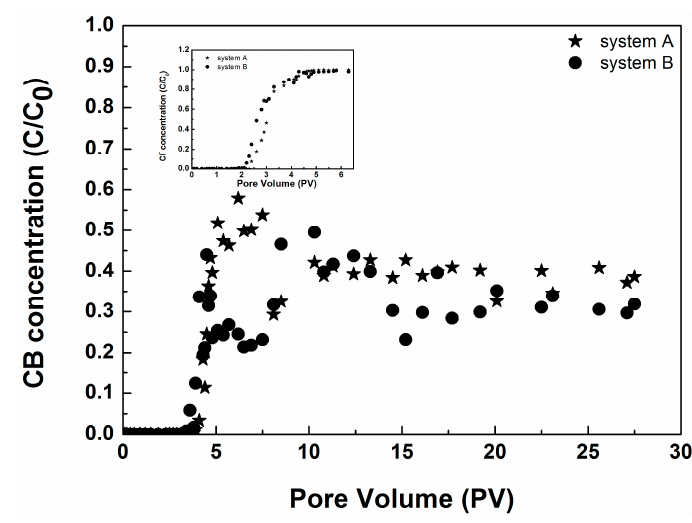
Figure 6. Variations in CB concentration profiles over times for column two of both systems. The inset displays the breakthrough curve of a sodium chloride (NaCl) tracer.